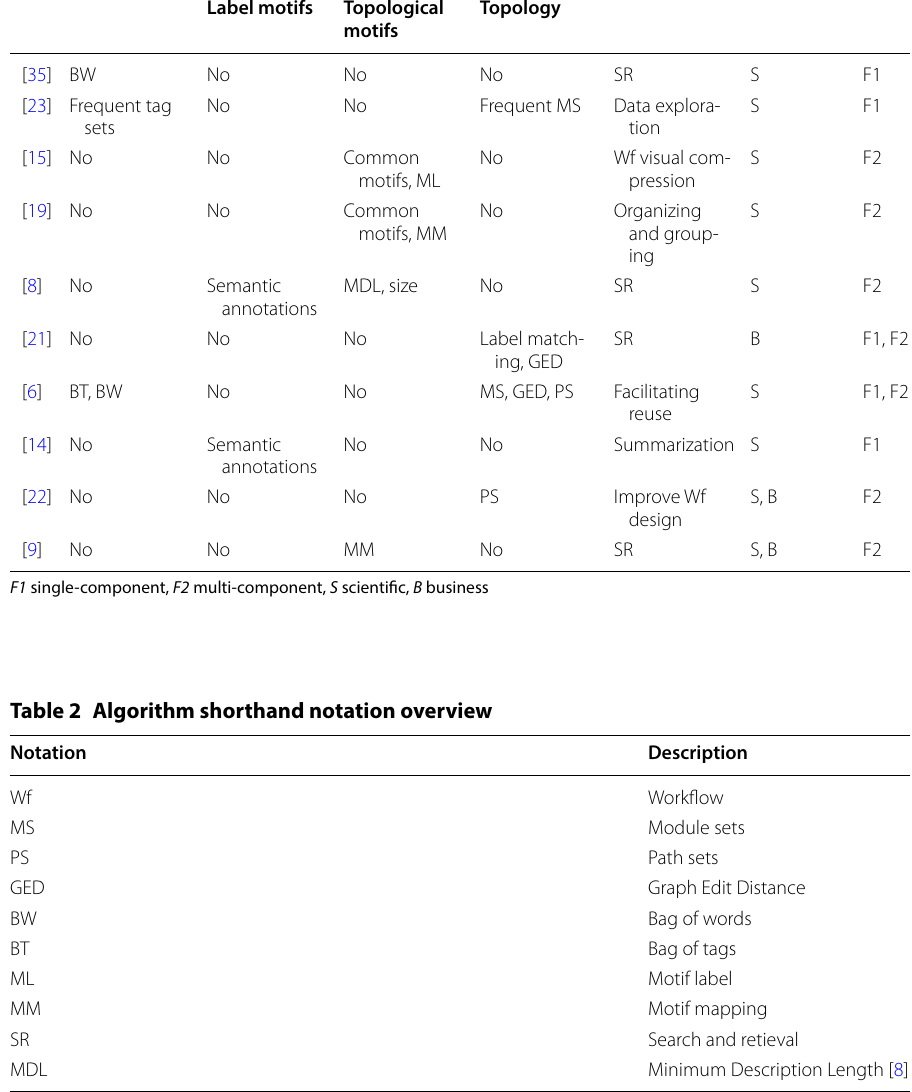
Table 1 Existing approaches to similarity assessment in workflow domains Ref.